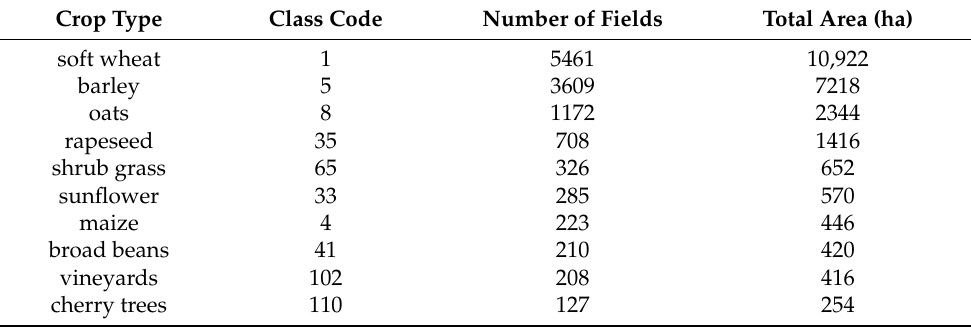
Table 2. Main characteristics of each crop